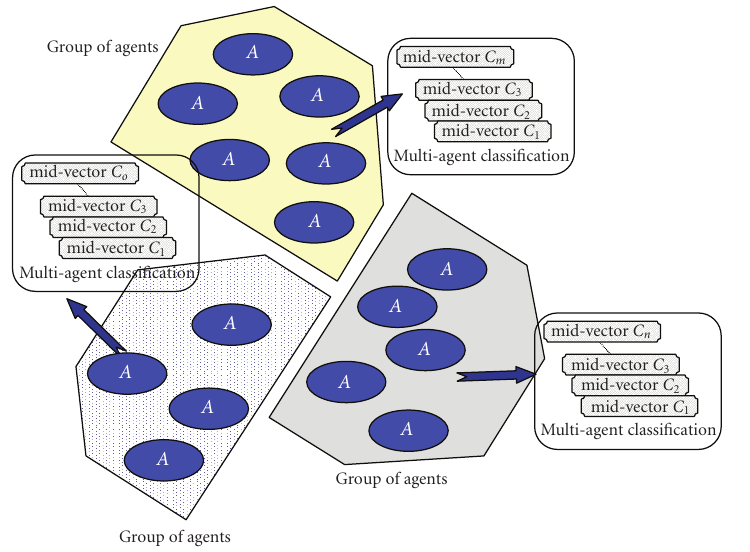
Figure 2: Multiagent classification.